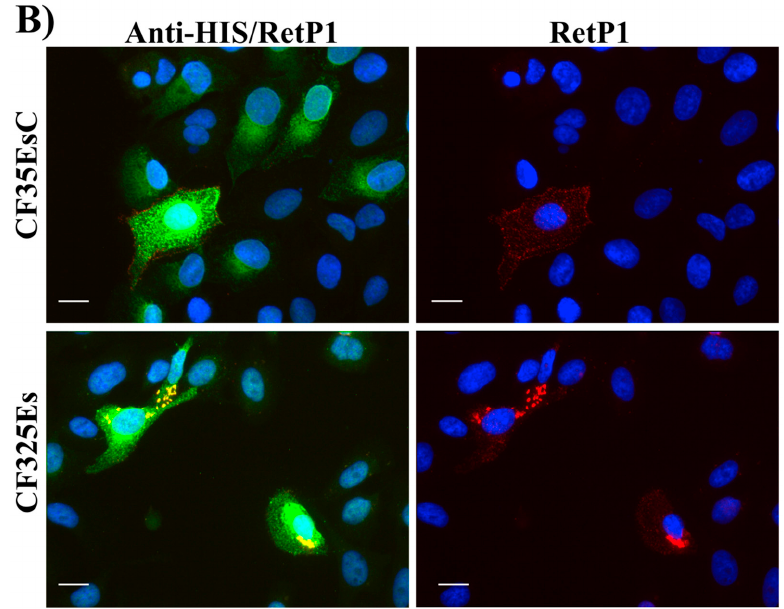
Figure 16. Subcellular localisation of hRHO P23H His-Tag in the presence of 9-cis-retinal ( A ), CF35EsC and CF35Es ( B ). 9-cis-retinal was tested at 5 µM, whereas CF35EsC and CF35Es at 20 µM. Anti-His/RetP1: merged image of RetP1 staining (red) and Anti-His Tag binding total rhodopsin staining (His Tag expressed at the C-terminus of rhodopsin, intracellular, post-permeabilisation with 0.1% Triton; green). RetP1: anti-rhodopsin antibody (extracellular N-terminus antibody, incubation prior to permeabilisation, red) staining only the protein exposed on the cell membrane. Nuclei were stained with DAPI (blue). Scale bars: 10 µm.